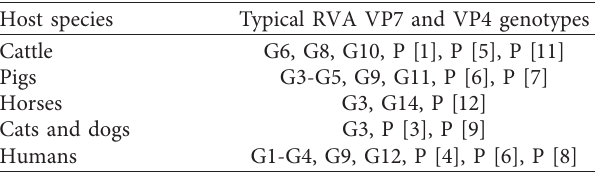
Table 3: Common RVA G and P genotypes found in humans and